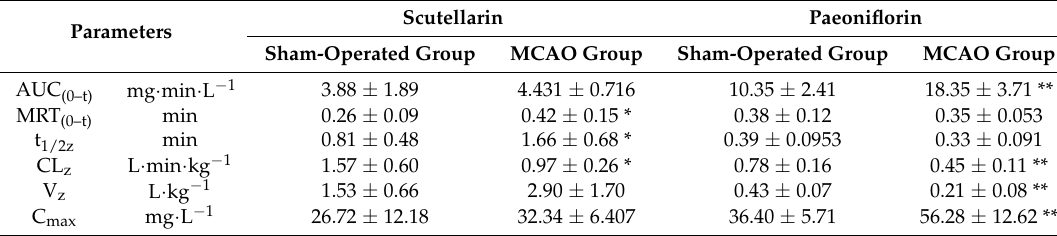
z : terminal volume of distribution; C max : maximum plasma drug